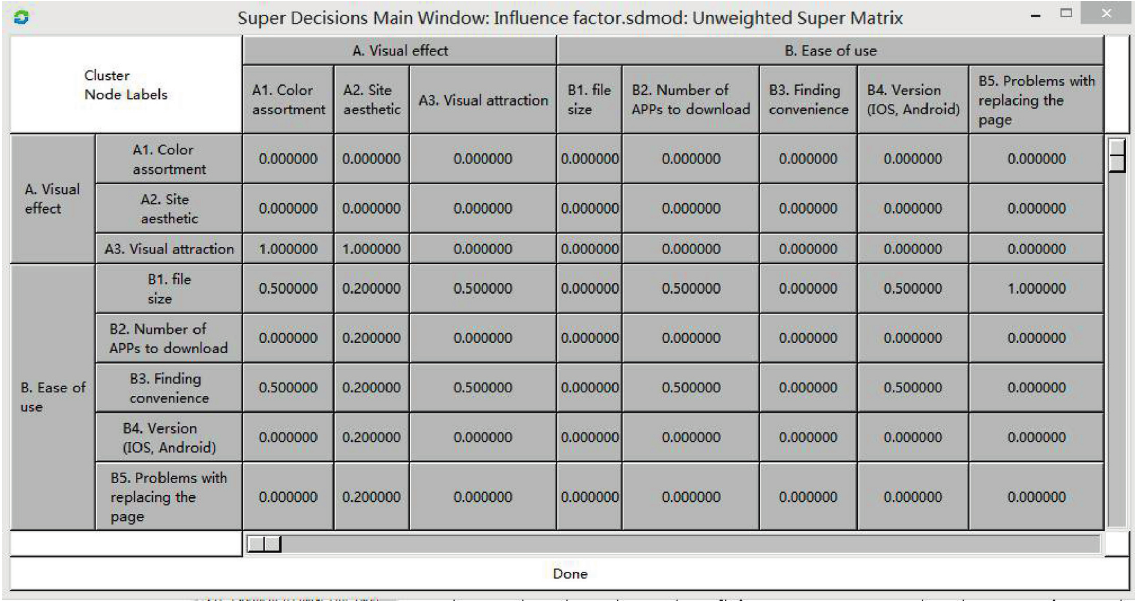
Figure 5: Implementation of the unweighted super